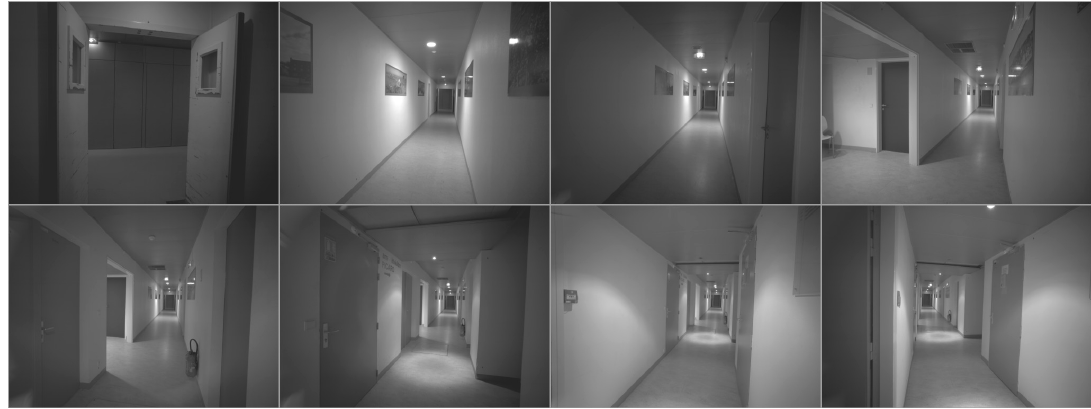
Figure 18. Some images from the Hallway dataset. Photogrammetric ultra light Camera IGN CamLight [40], 18 mm focal length.